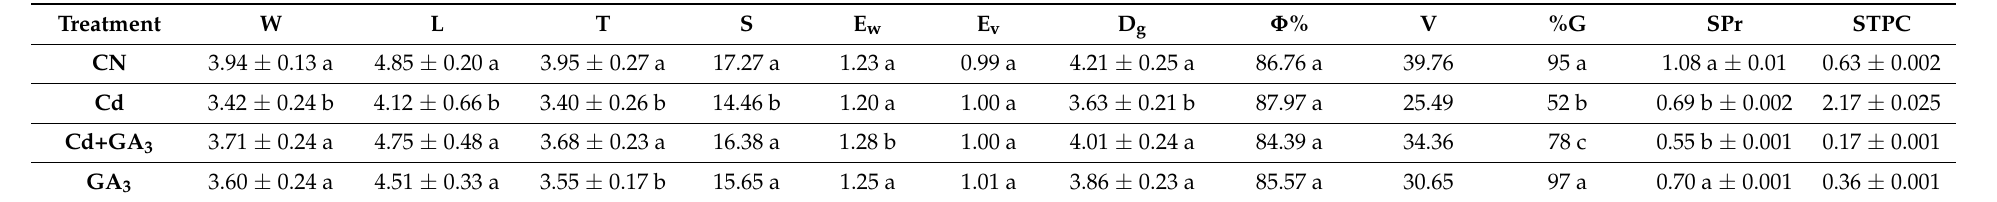
Table 2. Effect of cadmium (Cd) stress with or without gibberellins (GA 3 ) on seed geometric attributes viz. width (W), length (L), thickness (T), Sphericity (S), Ew, Ev, geometric mean (Dg), seed shape ( Φ %), volume of the grain (V), gravity (%G), seed protein content (SPr, mg g − 1 dry weight) and seed total phenol content (STPC, mg g − 1 dry weight) of seeds of mung bean plants subjected to control (CN), cadmium stress (Cd), gibberellins (GA 3 ), Cd+GA 3 at 30 days after sowing (DAS), 45 DAS, 60 DAS, and 75 DAS. Data presented are means ± standard errors ( n = 10, biological replicates). Different letters (a, b, c) indicate significant differences from control in all combinations (Tukey’s test, p ≤